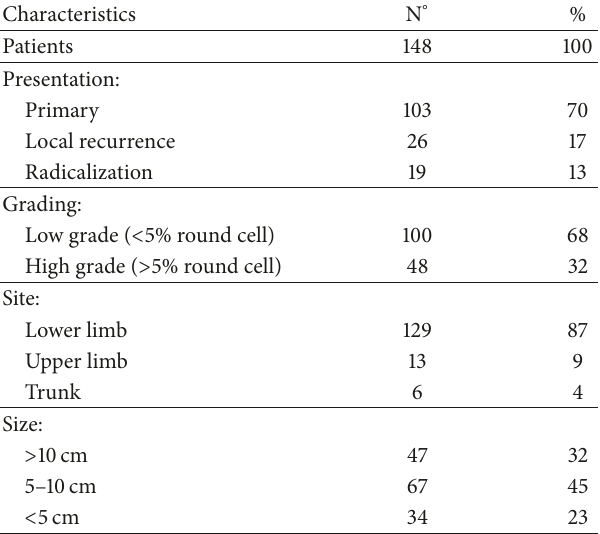
Table 1: Main features.